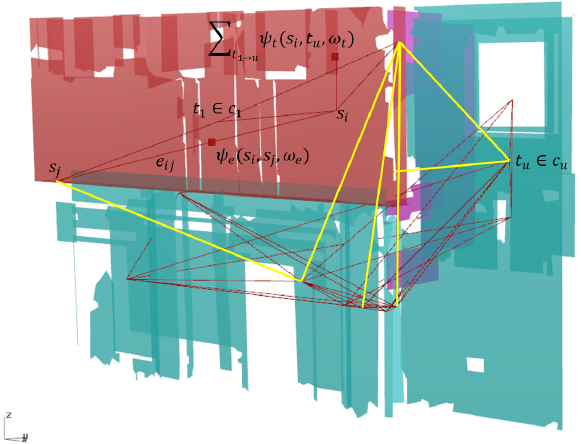
Figure 3: Illustration of the clustering using Conditional Ran- dom Fields within a connected component graph: given the seeds t 1 → u from the region growing, one of u labels is computed for each s given the factor graph with the edge and node potentials. The three clusters are depicted in red, cyan and purple, the edges are shown in red and the edges between clusters are shown in